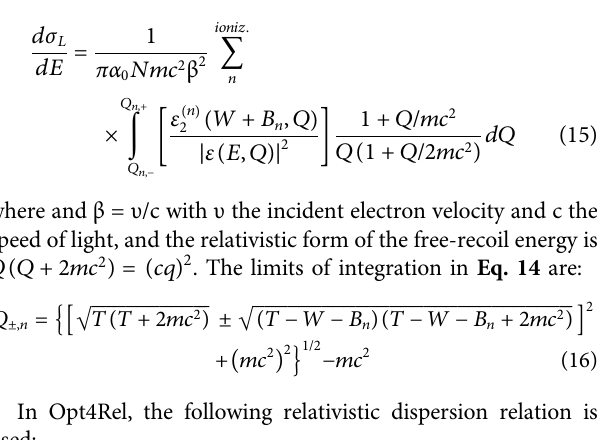
FIGURE 2 | Total ionization cross section of electrons in liquid water in theenergyrangefrom10 eVto1 MeV.ComparisonbetweenthedefaultOpt2 and new Opt4Rel Geant4-DNA physics models is shown. The inset focuses on the low-energy range (up to 10 keV) with the addition of the non- relativistic Opt4.